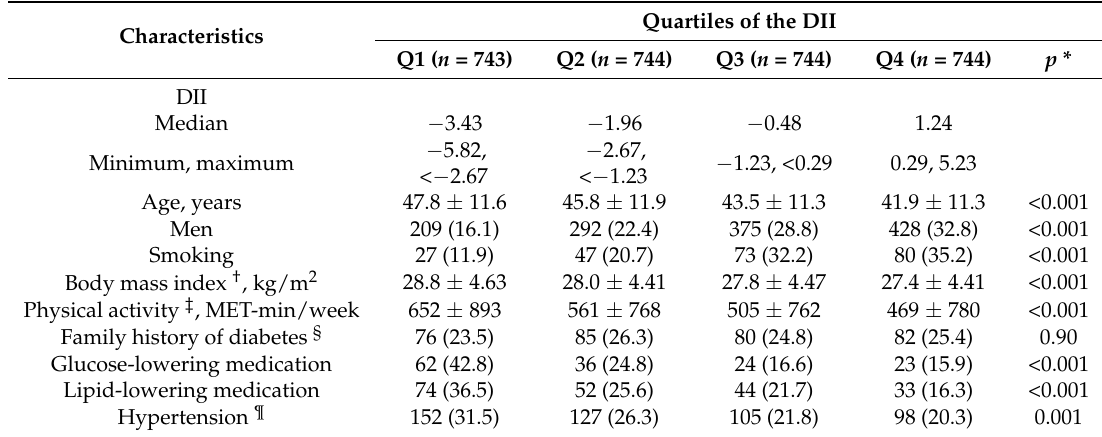
Table 1. Characteristics of participants according to the quartiles of the dietary inflammatory index (DII).